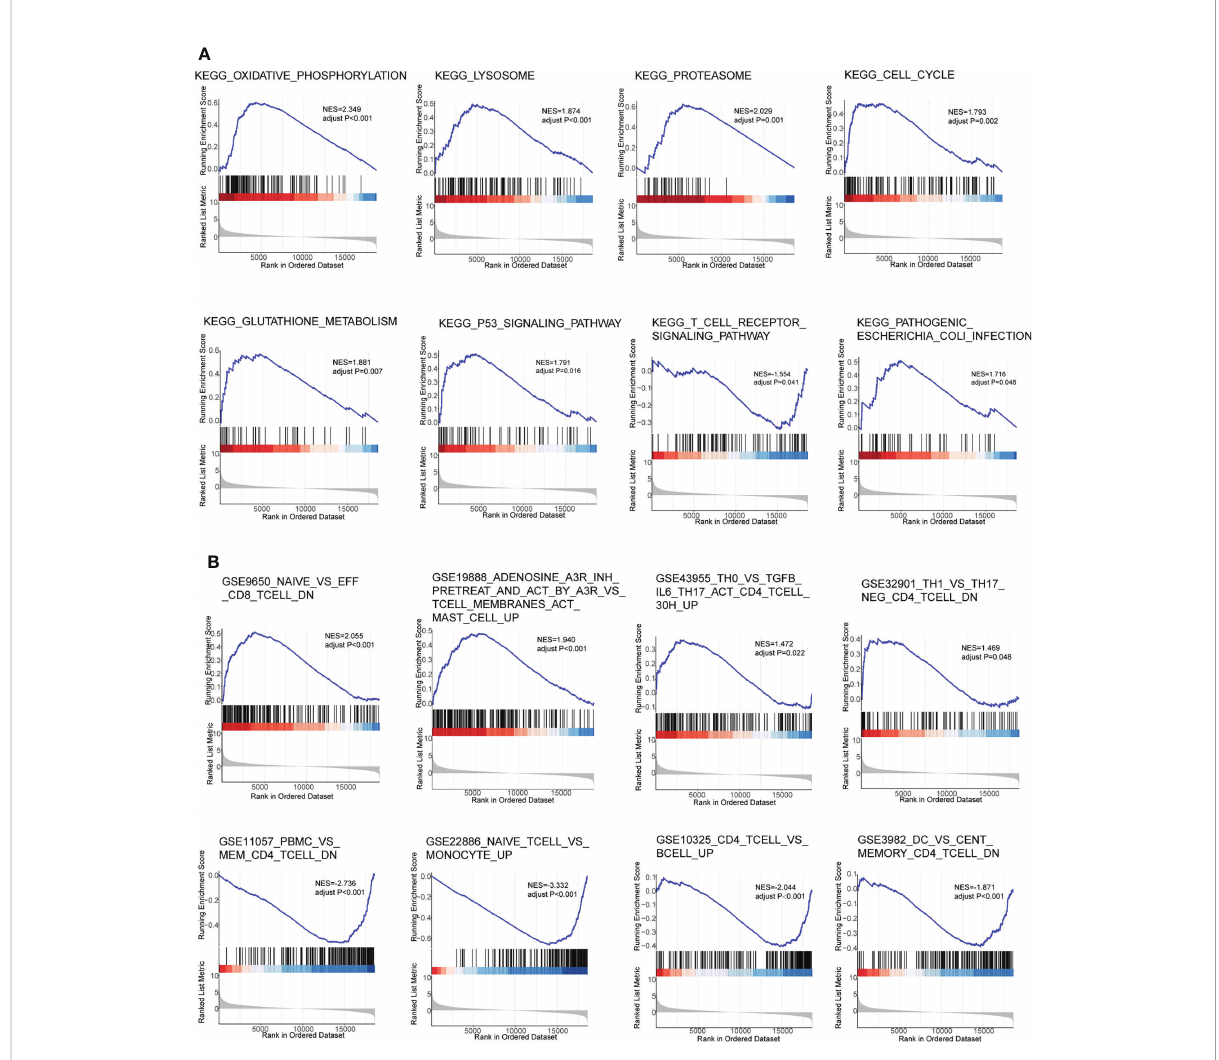
FIGURE 3 Gene Set Enrichment Analysis in GSE154918. (A) KEGG pathways. (B) Gene immunologic signature gene sets. KEGG, Kyoto Encyclopedia of Genes and